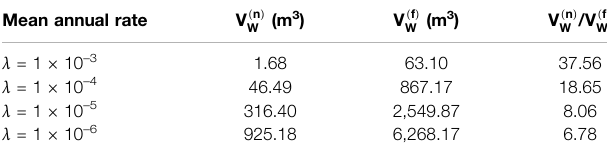
TABLE 3| Comparison betweentotalwateringressinthenominalhurricane( V ( n ) W ) and full hurricane ( V ( f ) W